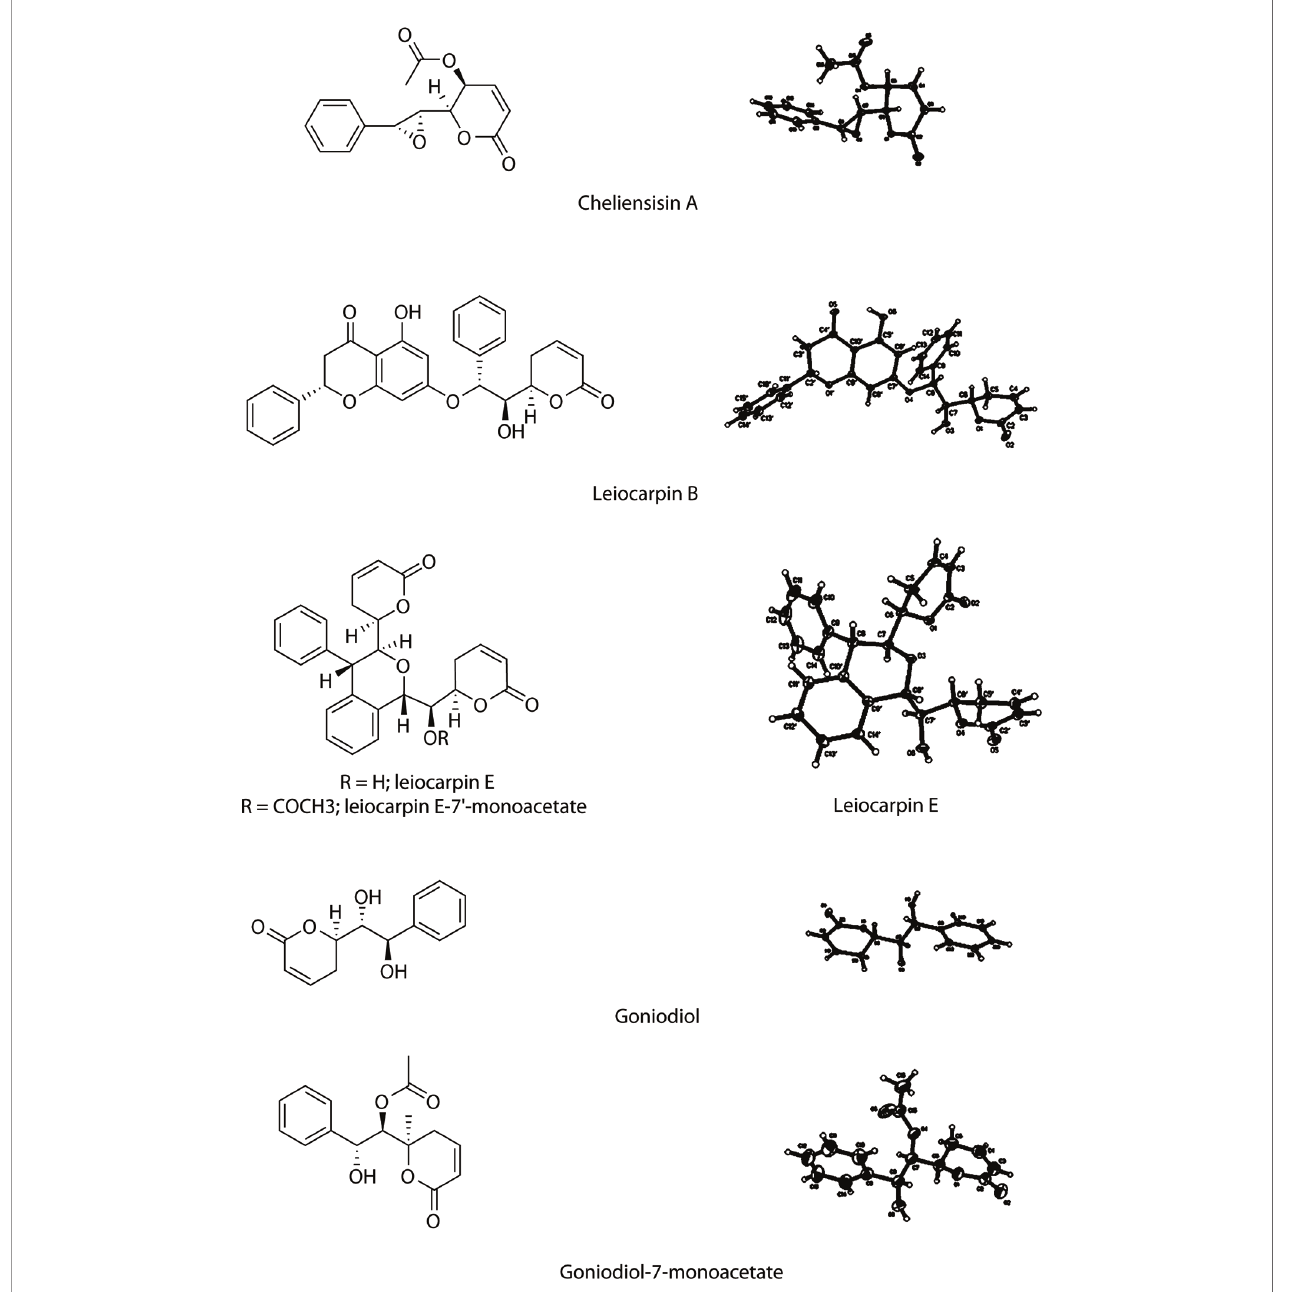
FIGURE 2 | Structure and X-ray crystallography of the